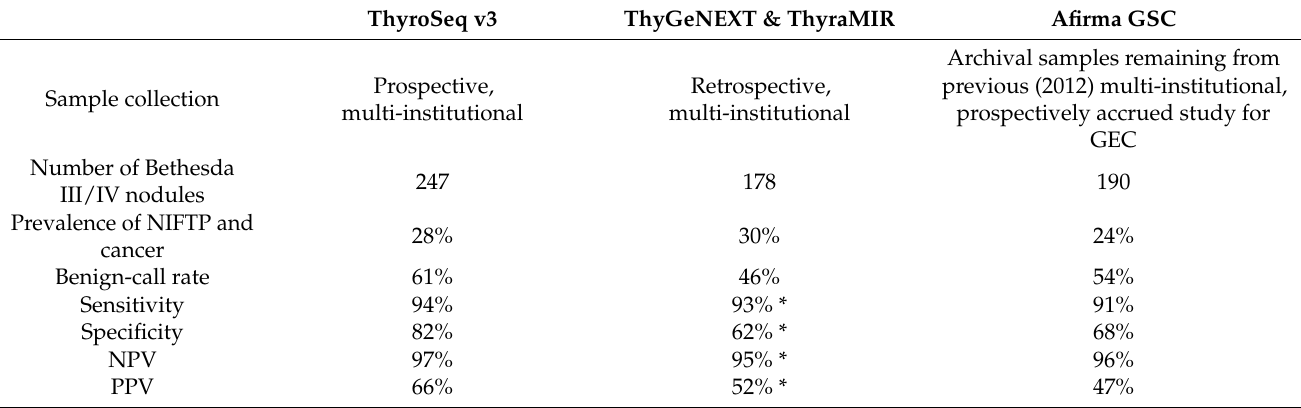
Table 3. Comparison of clinical validation studies for three commercially available molecular tests for cytologically indeterminate thyroid